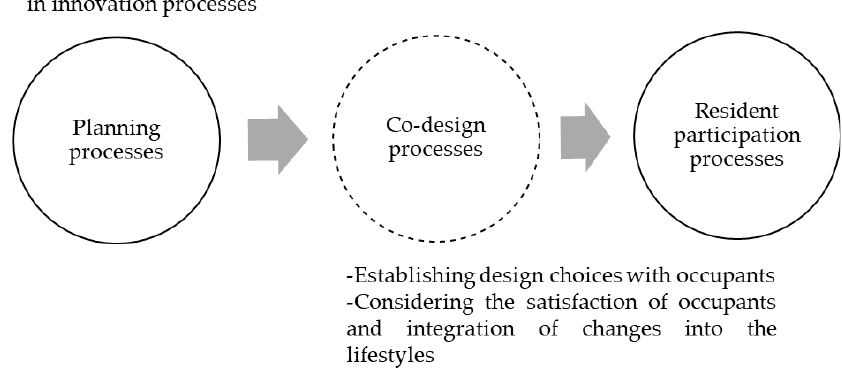
Figure 4. The importance of occupants ’ participation in the design process [93, 127].